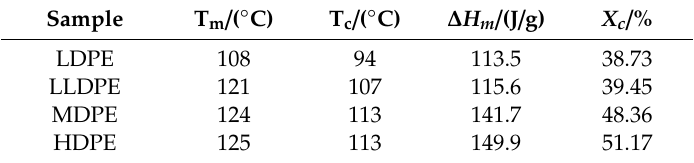
Figure 2. DSC curves of four kinds of polyethylene. (Low-density polyethylene, LLDPE; low-density polyethylene, LDPE; medium density polyethylene, MDPE; high-density polyethylene, HDPE). Table 1. Crystallization and melting process parameters of four kinds of polyethylene.